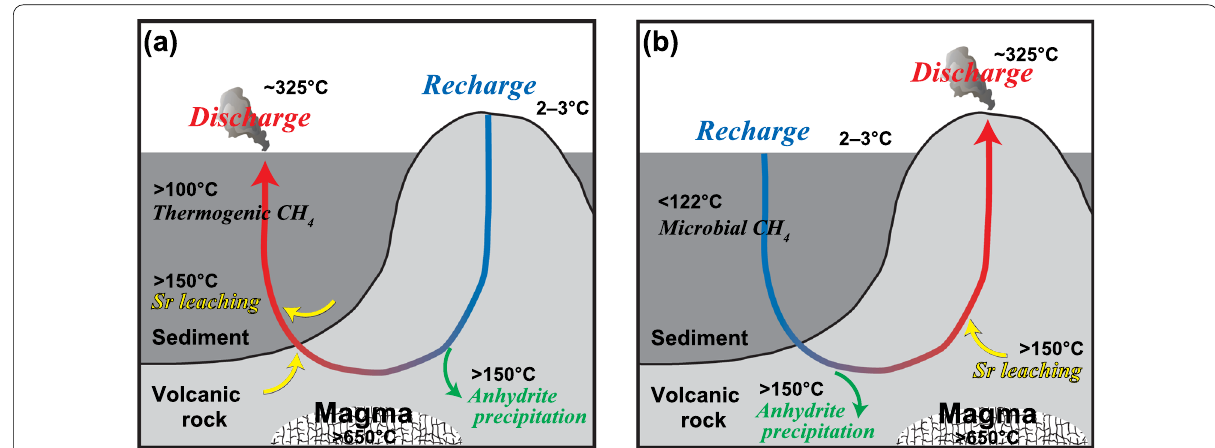
Fig. 6 Schematic diagram showing two types of hydrothermal circulation in the Okinawa Trough (modified after Kawagucci 2015). Arrows indicate hydrothermal fluid circulation, with color representing the temperature of hydrothermal fluid. a Hydrothermal circulation in contact with sediments at high temperatures and volcanic rocks at moderate temperatures (> 150 °C). Fluid is in contact with sediments at high temperatures, and the sediments supply Sr (e.g., Yonaguni Knoll IV). b Hydrothermal circulation in contact with sediments at low temperatures and volcanic rocks at high temperatures. Sr from volcanic rocks is supplied to hydrothermal fluids (e.g., Iheya North Knoll and Hatoma Knoll). Thus, CH 4 is provided by thermogenic CH 4 at high temperatures ( a ) and microbial sources at low temperatures ( b